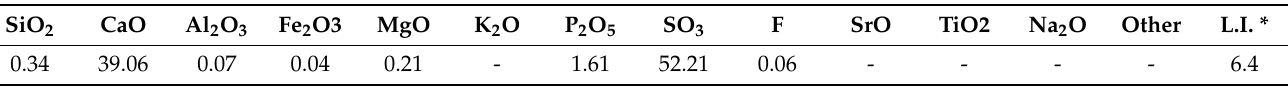
Table 2. The chemical composition (based on XRF analysis) of hemihydrate phosphogypsum from Kovdor, wt%.